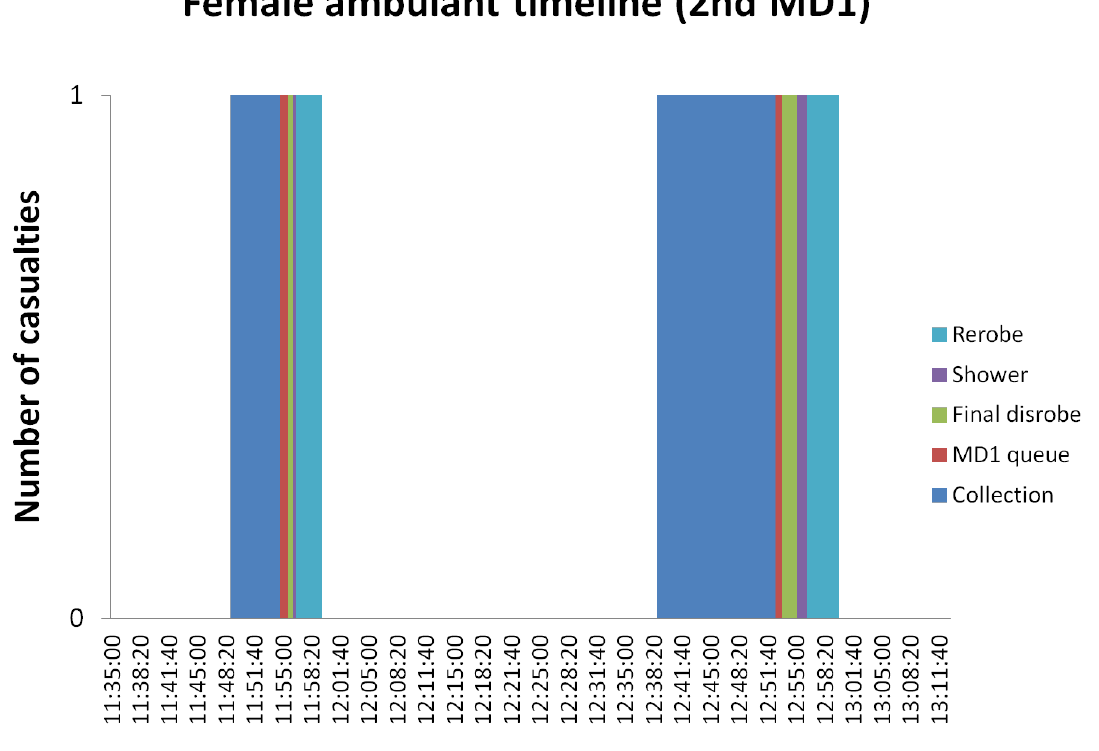
Figure A11. Only 2 female ambulant casualties passed through as described in the caption of Figure A9 both of whom spent more time in the re-robe section than in the final disrobe and shower sections